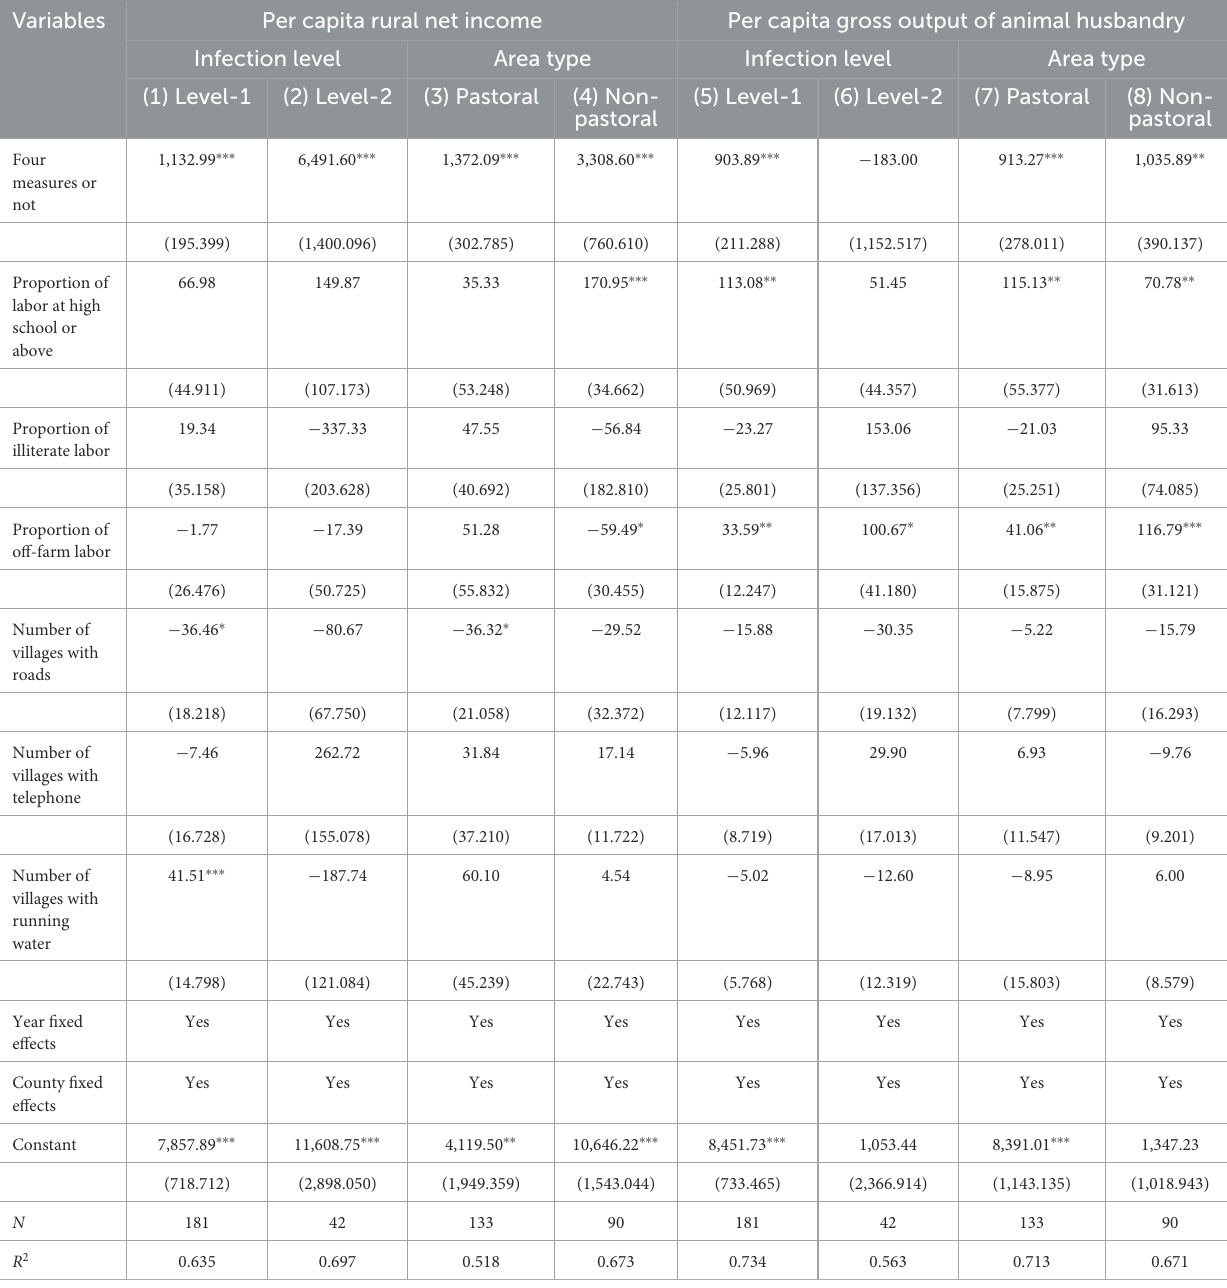
TABLE 7 Results of heterogeneity analysis of counties with different